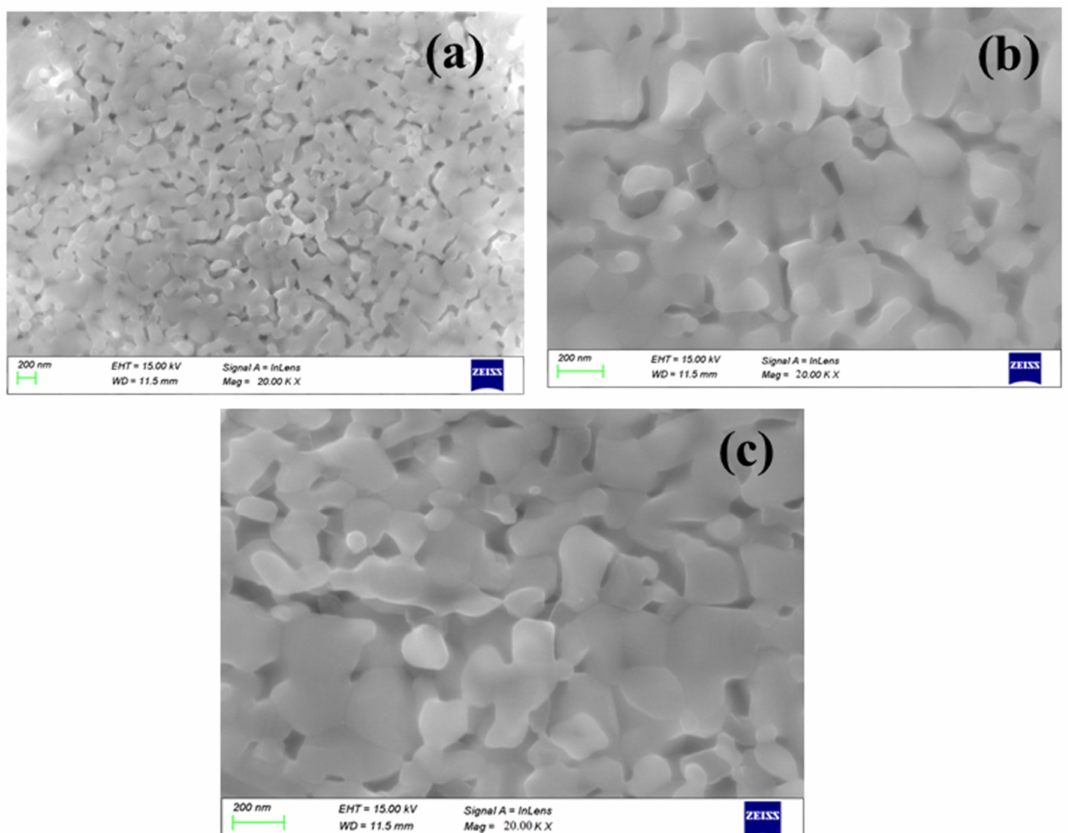
Figure 5. SEM morphology of: ( a ) BFO; ( b ) BDFO; and ( c ) BZFO thin